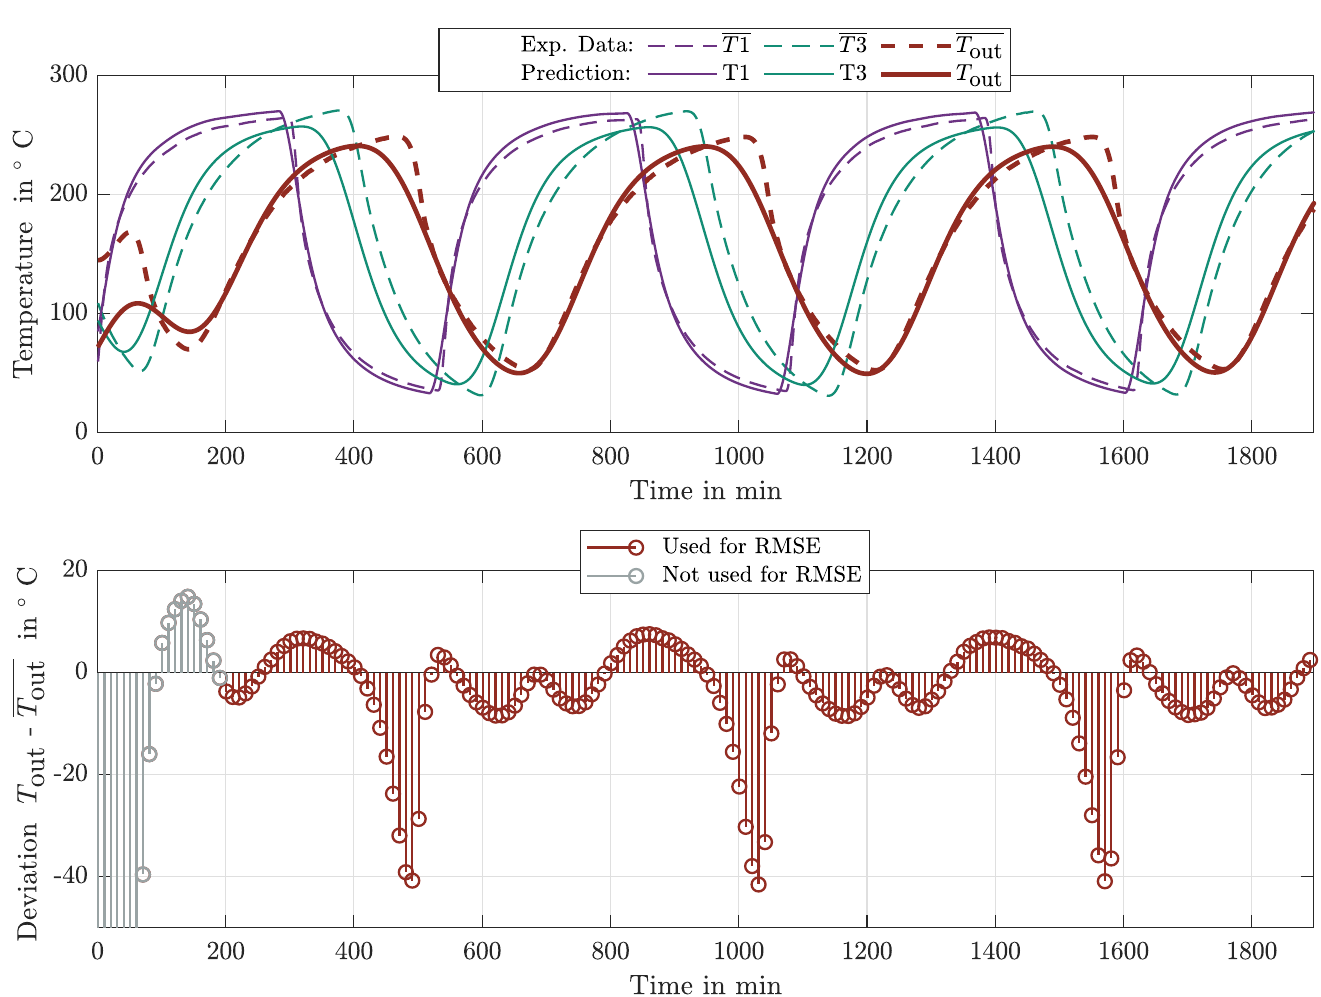
Figure 3. Results of the basic grey-box model for measurement series